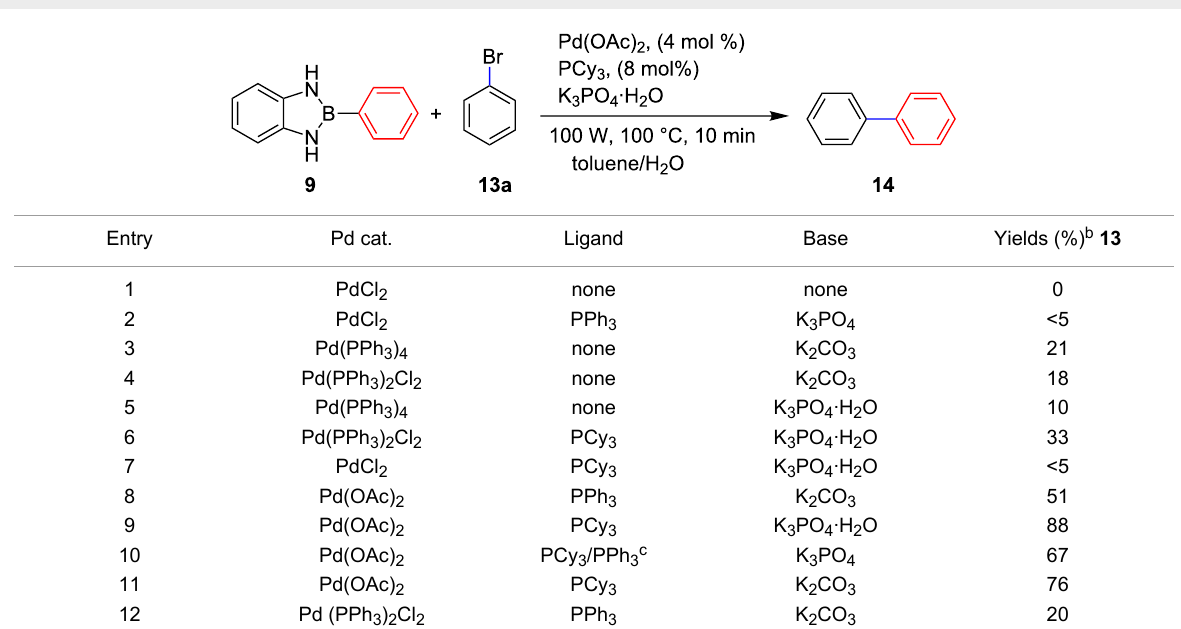
Table 1: Initial optimisation of reaction conditions. a